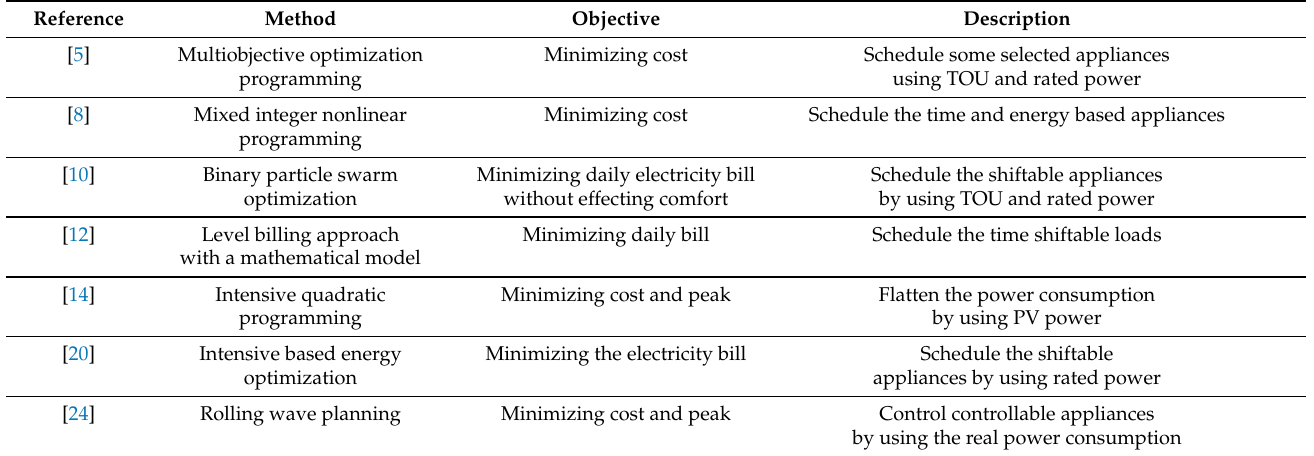
Table 1. Synthesis of remarkable REM studies in the